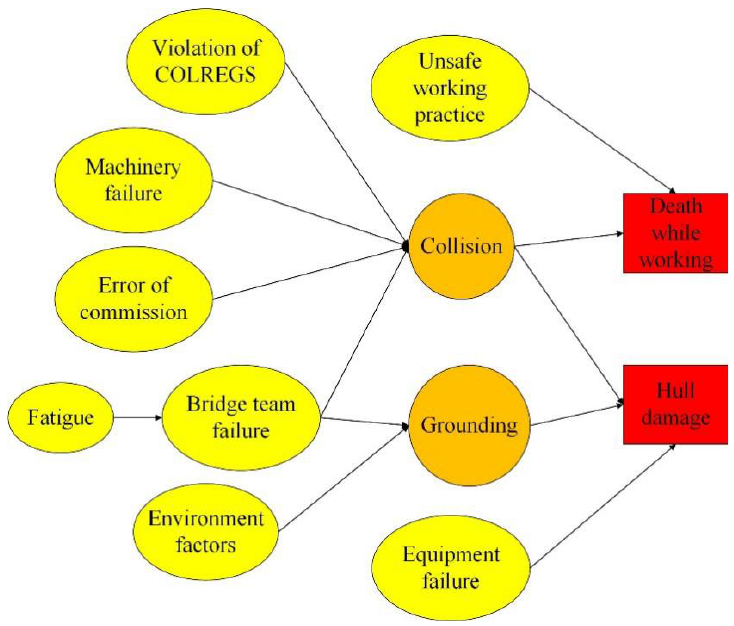
Figure 12. High frequency accident chain.